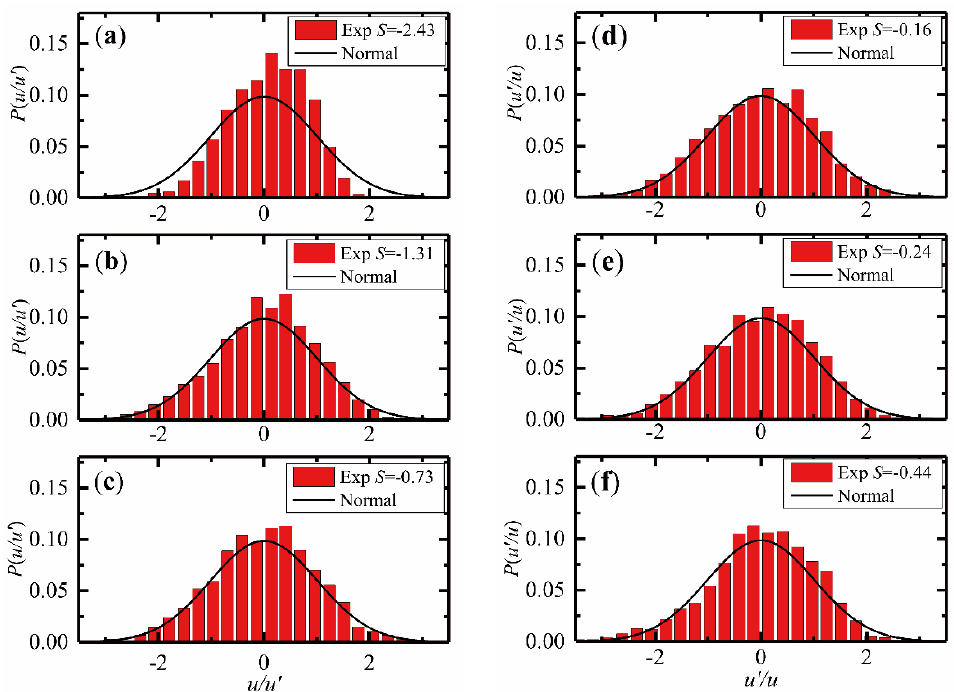
Figure 13. Probability distribution functions (PDFs) of stream-wise fluctuating velocities at x / M = 6 ( a ) z / M = 3.5; ( b ) z / M = 0.5; ( c ) z / M = − 3 and at x / M = 20 ( d ) z / M = 3.5; ( e ) z / M = 0.5; ( f ) z / M = − 3.